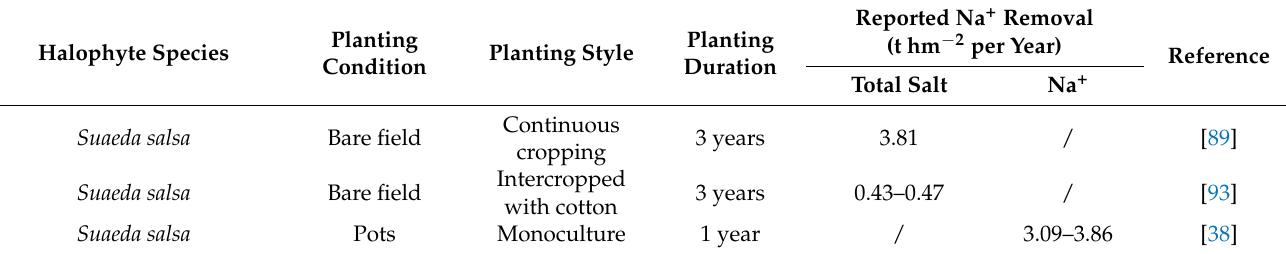
Table 2. Salt removal capacity of some